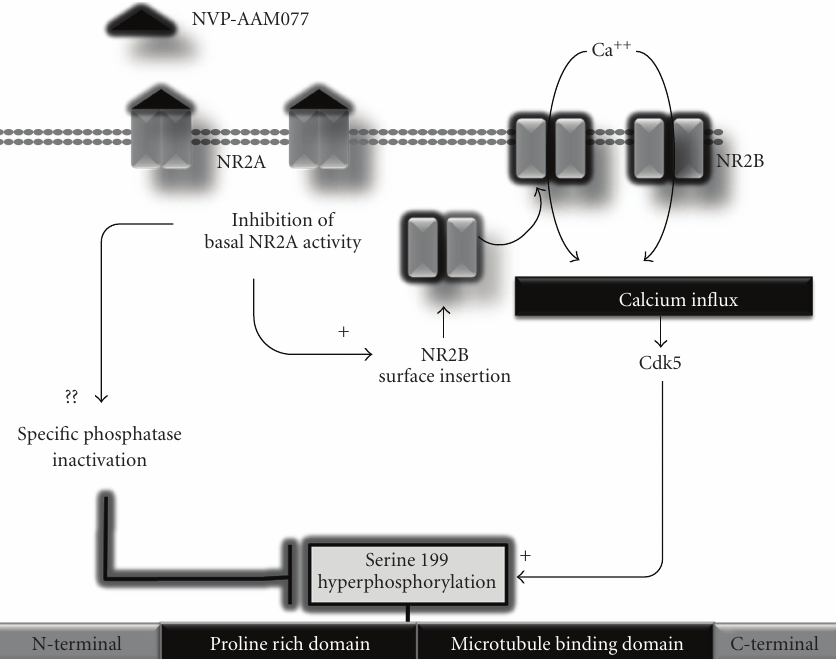
Figure 6: Working model of NVP-induced Tau phosphorylation. Blockade of NR2A-containing receptors appears to initiate the insertion of new functional NMDA receptors containing a high proportion of NR2B subunits in neuronal plasma membranes, promoting calcium accumulation. Through an unknown mechanism, Cdk5 activity would selectively enhance the phosphorylation of Ser199 residue in the proline-rich domain of Tau. In parallel, blockade of NR2A-containing receptors may reduce specific phosphatase activity which could have an impact on Tau phosphorylation at